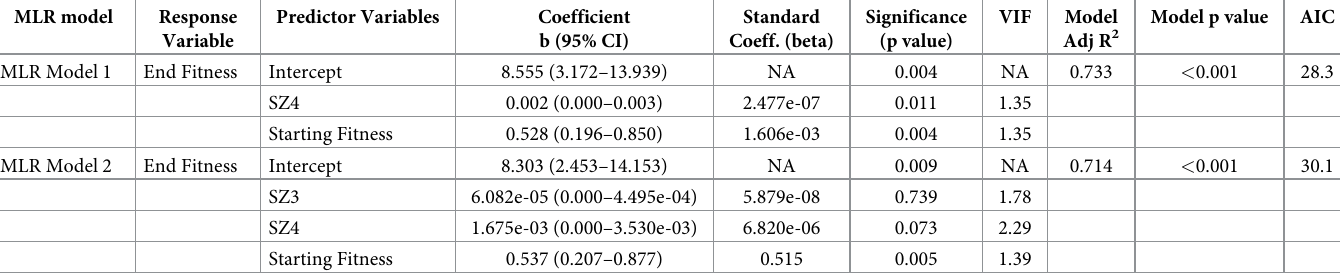
Table 7. Results of refined MLR models with respective variable inflation